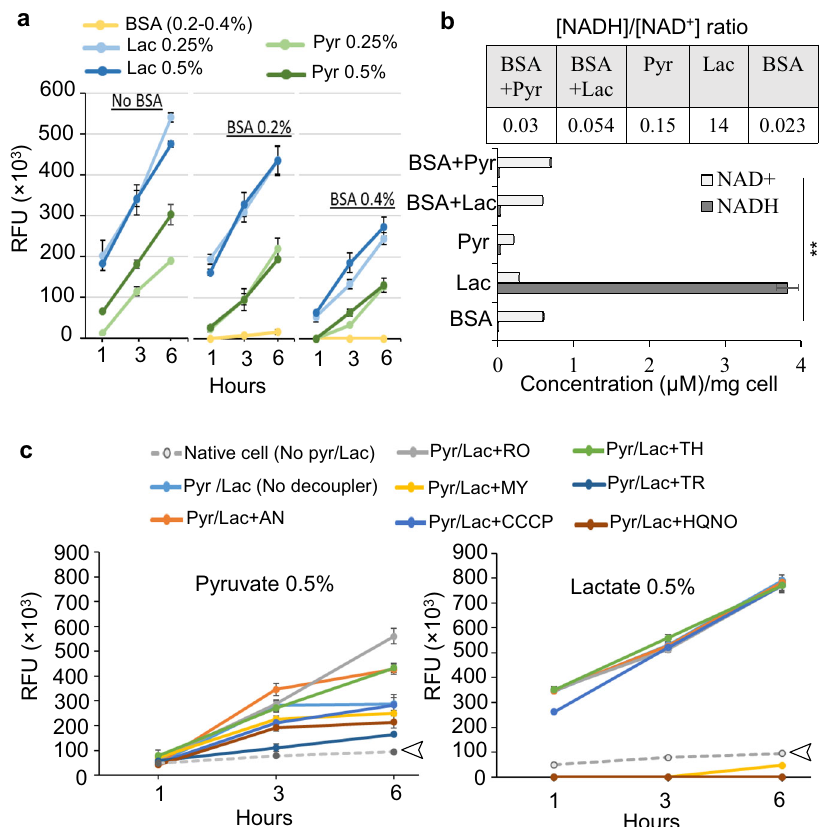
Fig. 4 The impact of proteinaceous substrates, pyruvate, and lactate on the redox status of P. gingivalis . a Resazurin fl uorometric (RF) assay indicates that exogenous lactate and pyruvate greatly change cellular redox status, but BSA utilization does not; concomitant utilization of BSA and pyruvate or lactate effectively controls redox changes. b Quanti fi cation of [NADH]/[NAD + ] cofactors shows that the metabolism of BSA enhances cellular accumulation of [NAD + ] when compared with the utilization of exogenous pyruvate that reduces it. Lactate metabolism remarkably favored cellular accumulation of [NADH] and the increase of [NADH]/[NAD + ] ratio, while it is signi fi cantly lowered upon BSA addition. c The use of a series of chemical uncouplers in RF assay to shed light on the bioenergetics system of P. gingivalis and the effects of pyruvate and lactate on it. RF assays over 6-h incubation period indicated that the uncouplers HQNO (a potent inhibitor of quinone oxidation at the Na + – NQR complex in bacteria), TR (a calmodulin antagonist and type II NADH oxidoreductase (NDH-2) inhibitor in M. tuberculosis ), and MY (a Q o site inhibitor at cytochrome b ) have strong inhibitory effects on lactate-induced redox changes upon decoupling electron transport system from lactate metabolism while others, including AN, RO, CCCP, and TH did not show inhibitory effects. The uncouplers HQNO, TR, and MY were less inhibitive to pyruvate-induced redox change. Arrows indicate the basal redox status of the cells in the absence of any treatment. The data in graphs represent the means ± SD error for biological replicates ( n = 4), and asterisk in the bar graph indicates signi fi cantly different values (post hoc Tukey ’ s HSD test: ** p < 0.01). RFU relative fl uorescence units, BSA bovine serum albumin, Pyr pyruvate, Lac lactate, HQNO 2-heptyl-4-hydroxyquinoline N-oxide, TR tri fl uoperazine, MY myxothiazol, AN antimycin A, RO rotenone, CCCP carbonyl cyanide m-chlorophenyl hydrazine, TH thenoyltri fl